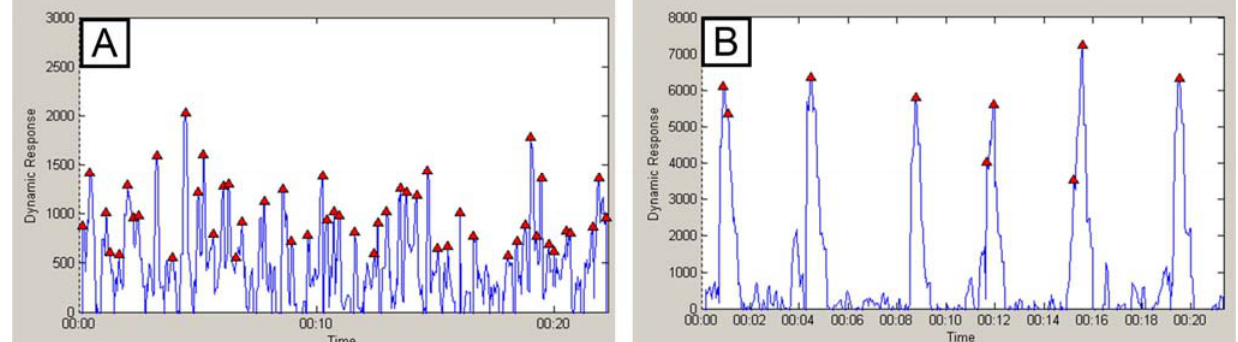
Figure 7. Representative records of the Ca 2+ intracellular wave in beating cardiomyocyte determined by an Fura4 probe. Record of hiPSC-CM growing on native ( A ) and macro-structured ( B ) surfaces. HiPSC-CM photos and Ca 2+ waves were computed from the camera record. The fluorescence microscope was fitted for green fluorescence.